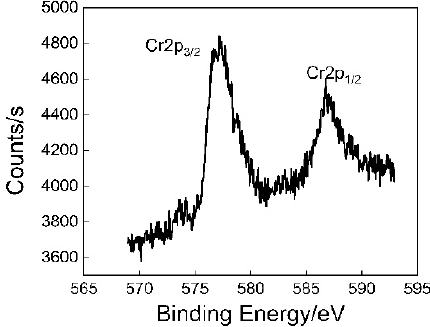
Figure 9. The XPS spectra of Cr in the TFS.